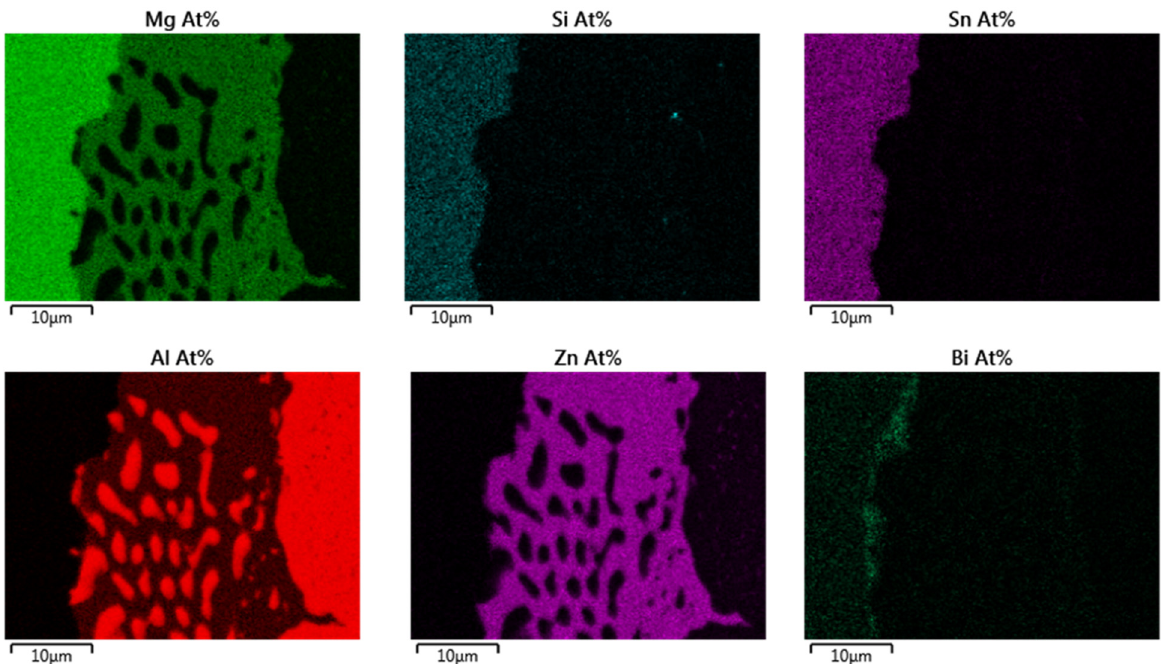
Figure 3. EDX mapping of a reaction area between Al, Zn and the Mg 2 (Si,Sn) TE material.